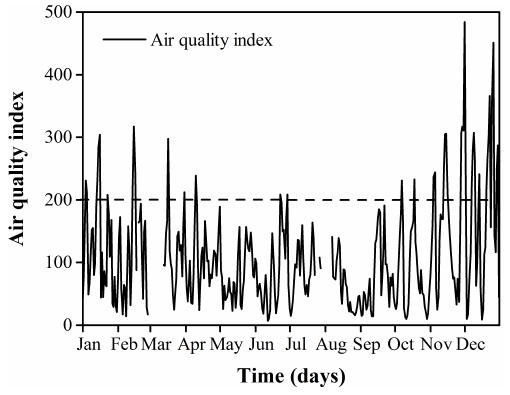
Figure 1. Daily mean air quality index during 2015 in Beijing, China. Air quality index is stratified into six categories: 0–50 for low, 51–100 for low to mild, 101–150 for mild, 151–200 for mod- erate, 201–300 for severe and >300 for serious air pollution